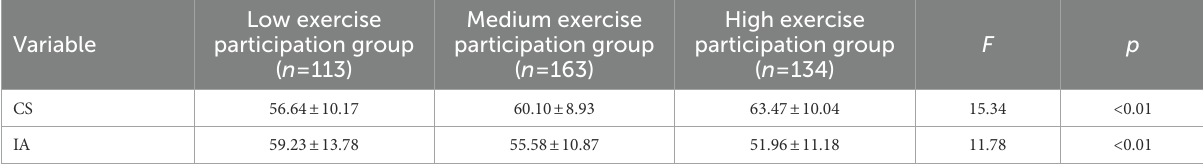
TABLE 3 One-way ANOVA for the effect of different amounts of PA on CS and IA.